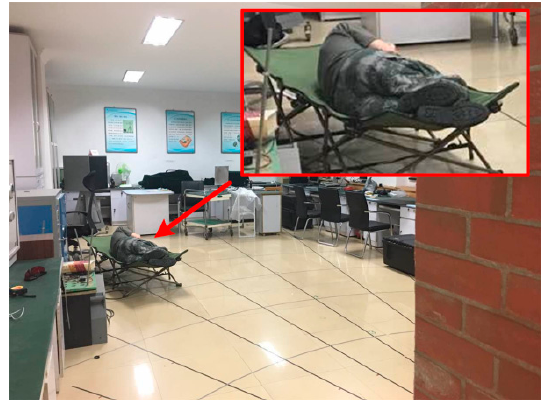
Figure 5. Measurement of the volunteer that curled upon a camp bed with his feet pointing to the transmitting antenna. In the figure, he was positioned approximately at (6 m, − 20°) away from the origin, namely the transmitting antenna.